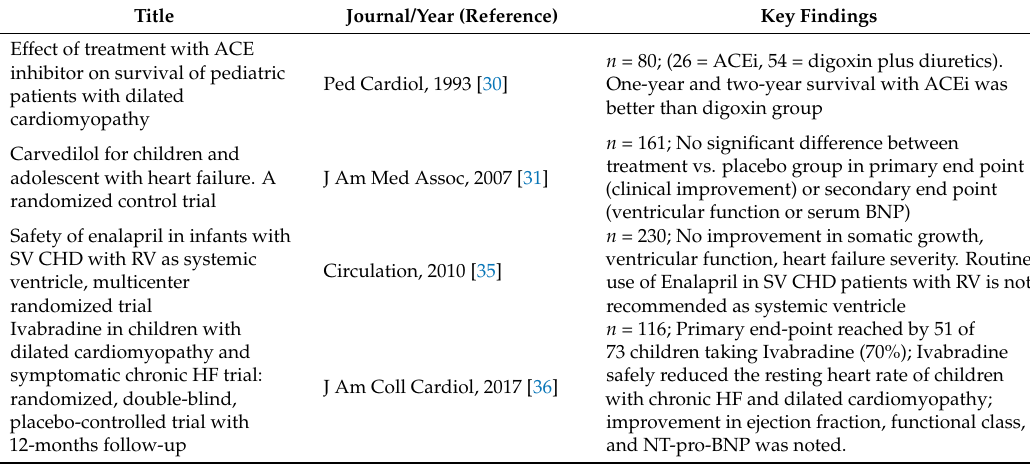
Table 5. Summary of important pediatric heart failure clinical